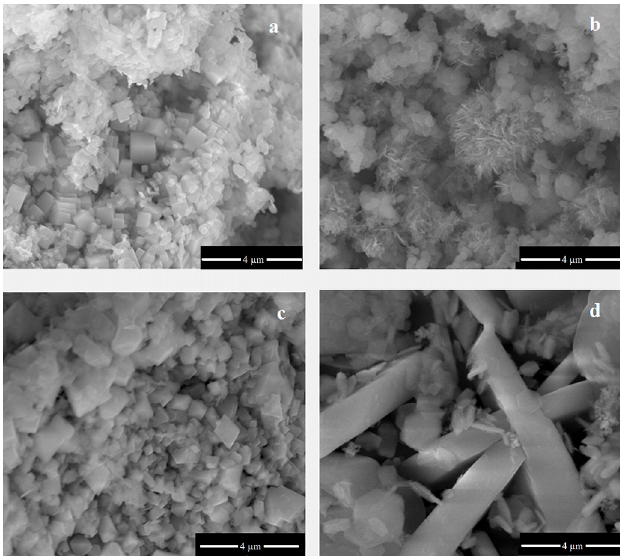
Fig. 2. Scanning electron microscopy images for (a) ZnTa 2 O 6 , (b) ZnNb 2 O 6 , (c) MgTa 2 O 6 and (d) MgNb 2 O 6 nanomaterials.